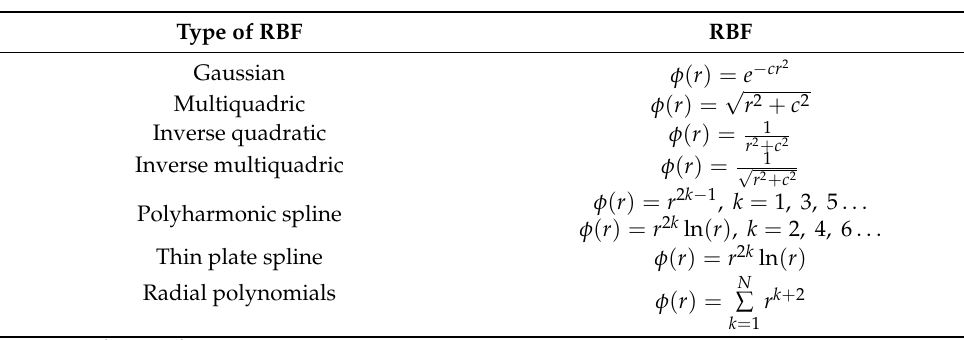
Table 1. Types of RBF.